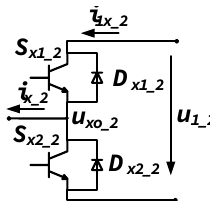
Figure 1. The topology of a single two-level arm.